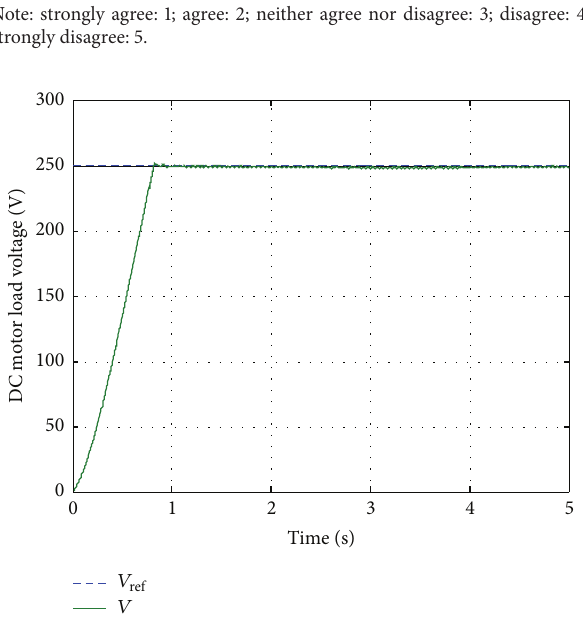
Figure 11: DC motor load voltage waveform.